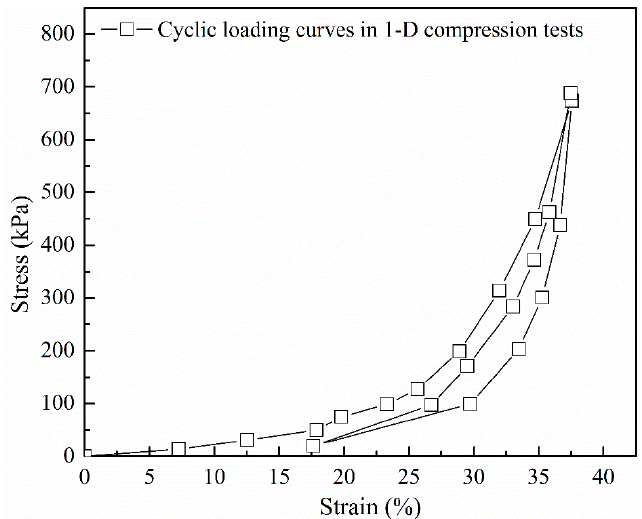
Figure 9. Displacement response for loading–unloading–reloading cycles in marcoscopic tests (reproduced by the authors, after Edil and Bosscher [2]).